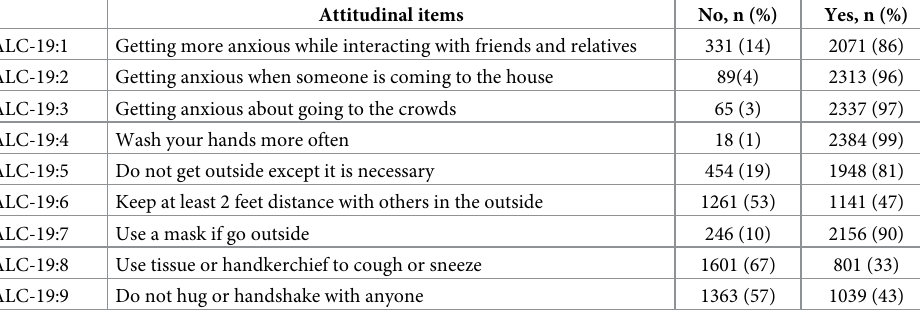
Table 2. Frequency of the statement related with attitude level on COVID-19 (ALC-19).